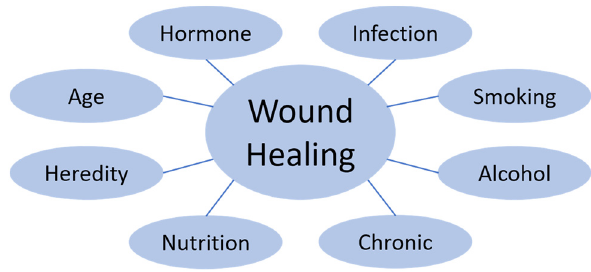
Figure 3: Factors a ff ecting wound